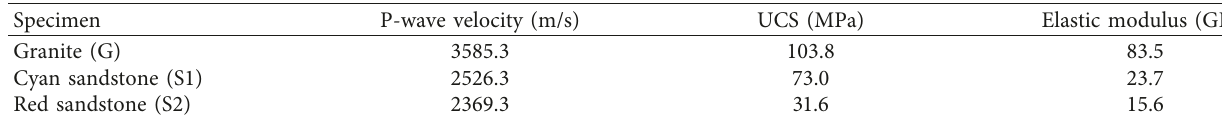
Table 1: Physical and mechanical parameters of